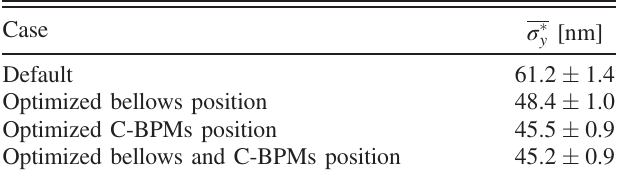
TABLE VII. Impact of the wakefield knobs on the